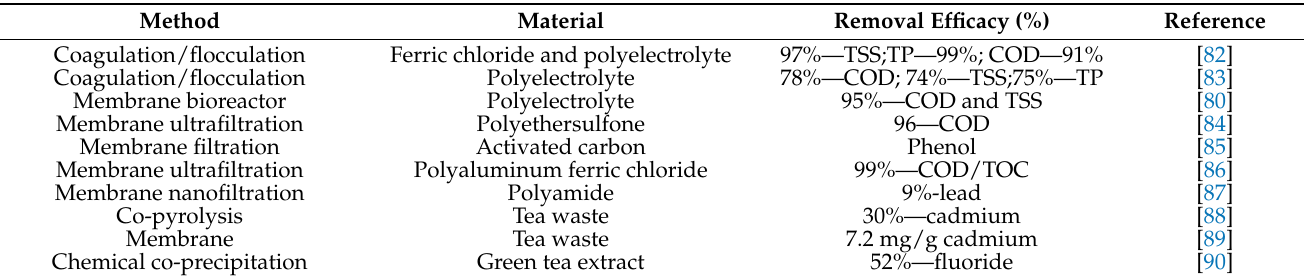
Figure 8. Tea manufacturing process. Table 6. Research work focused on wastewater